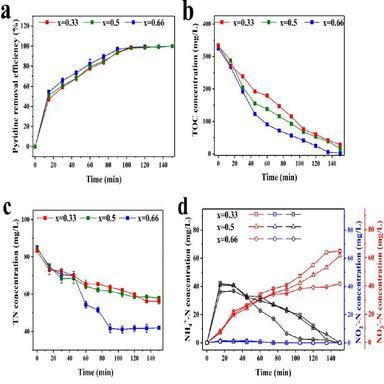
a) Pyridine removal efficiencies of the MnxCu1-xOy/γ-Al2O3 catalyst systems. Changes in b) TOC and c) TN for the MnxCu1-xOy/γ-Al2O3 catalyst systems. d) Nitrogen product selectivity in the MnxCu1-xOy/γ-Al2O3 catalyst systems (Reaction conditions: Temperature: 25 °C, Pyridine wastewater treatment capacity: 1 L, Ozone concentration: 35 mg/L).